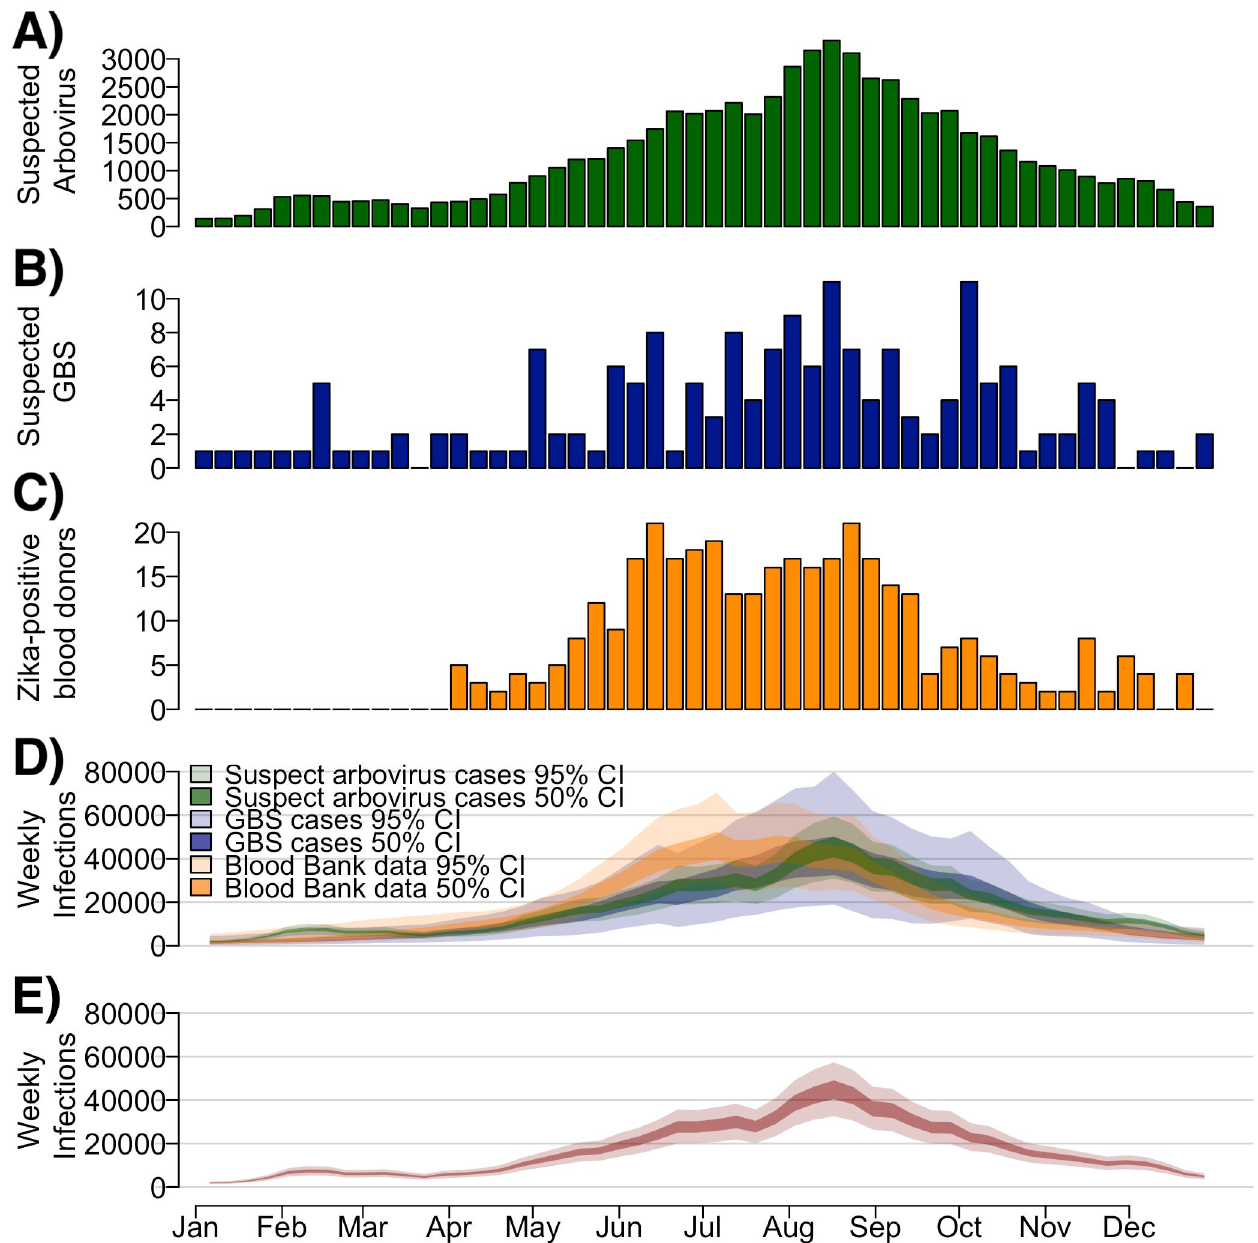
Fig 1. Suspected arbovirus cases, suspected ZIKV-associated Guillain-Barre´ Syndrome (GBS) cases, ZIKV-positive blood donors, and estimated weekly Zika infections during the 2016 outbreak in Puerto Rico. A) Number of suspected arbovirus cases reported (green). B) Number of suspected ZIKV- associated GBS cases reported. C) Number of ZIKV-positive blood donors identified from blood donor screening. D) Estimated weekly infections using each indicator model separately. Colors refer to each specific indicator used. E) Estimated weekly infections from a model using three combined surveillance indicators. Dark bounds refer to the 50% range (interquartile range) and lighter bounds refer to the 95% credible interval (CrI).